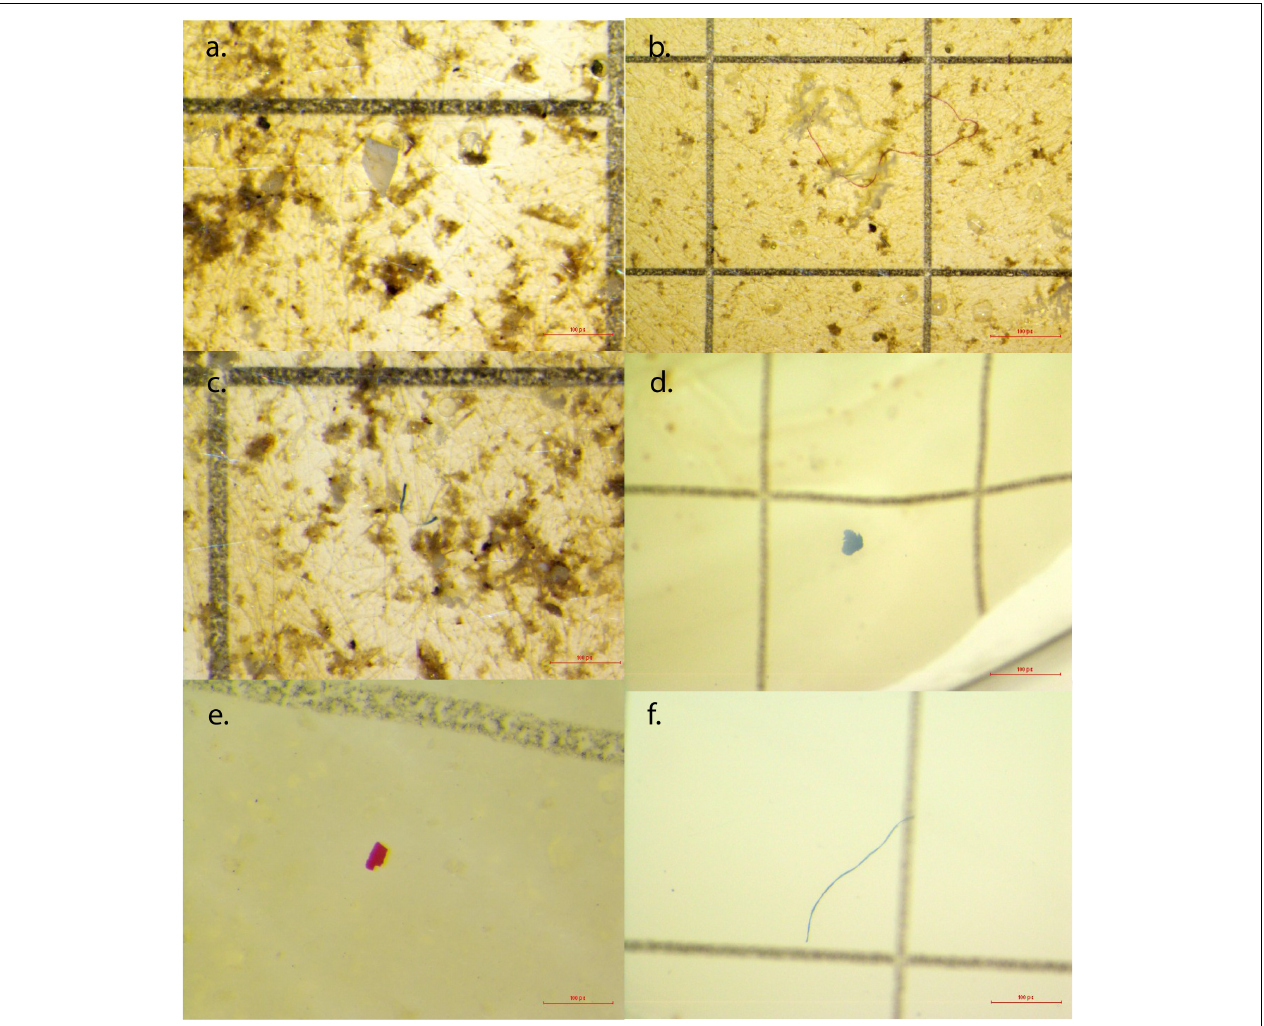
FIGURE 3 | Examples of microplastics from seawater samples and snail tissues. (a) Clear microfragment from Shell Point Park seawater sample; (b) red microfiber from Sand Key Park seawater sample; (c) blue and clear microfiber from Shell Point Park seawater sample; (d) blue microfragment from Crown conch snail tissue from Sand Key Park; (e) red microfragment from Crown conch snail tissue from Shell Point Park; (f) blue microfiber from Red-mouth rock shell tissue from 3-Mile